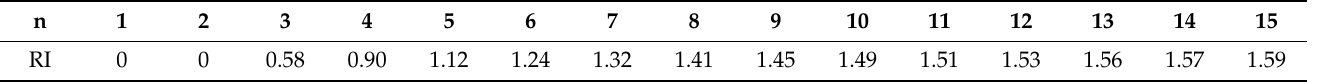
Table 2. Random consistency index.